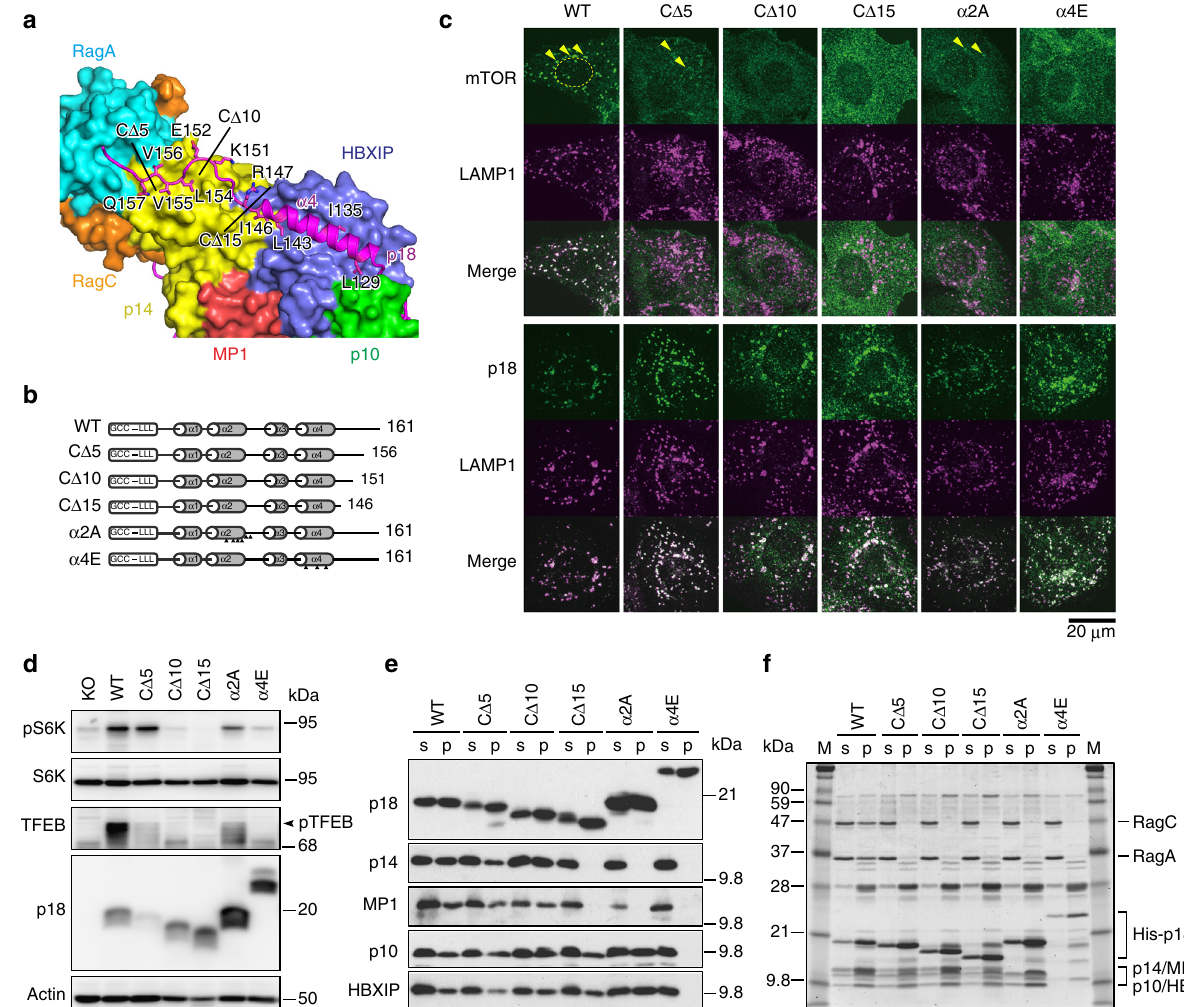
Fig. 4 Effects of p18 mutations on the assembly and function of Ragulator-RagA-C complex. a Ribbon model representation of the C-terminus of p18 depicted on the molecular surface of HBXIP, p14, p10, RagA(RD), and RagC(RD). Mutated amino acids and deleted regions tested in cellular and in vitro experiments (C Δ 5, C Δ 10, and C Δ 15) are indicated. b Schematic structures of p18 mutants. Arrowheads indicate the locations of amino acid substitutions. c p18 KO cells (KO) were transfected with wild-type p18 (WT), C-terminal deletion mutants (C Δ 5, C Δ 10, and C Δ 15), and mutants with multiple substitutions in the α 2 helix ( α 2A) and the α 4 helix ( α 4E), and subjected to immunostaining for mTOR, p18, and LAMP1. Arrowheads indicate the locations of lysosomal puncta. Dotted lines denote nuclei. d Total cell lysates prepared from the above cells were subjected to western blotting for the indicated proteins. e E. coli expressing p14, MP1, p10, HBXIP, and the indicated mutants of His-tagged p18 were lysed, and complexes were precipitated with HisTrap beads. Soluble lysates (s) and precipitates (p) were subjected to western blotting for the indicated proteins. f Ragulator was puri fi ed from the above precipitates and mixed with the puri fi ed RagA-C complex, and then reprecipitated with HisTrap beads. Soluble lysates (s) and precipitates (p) were subjected to SDS-PAGE, followed by Coomassie Brilliant Blue (CBB)